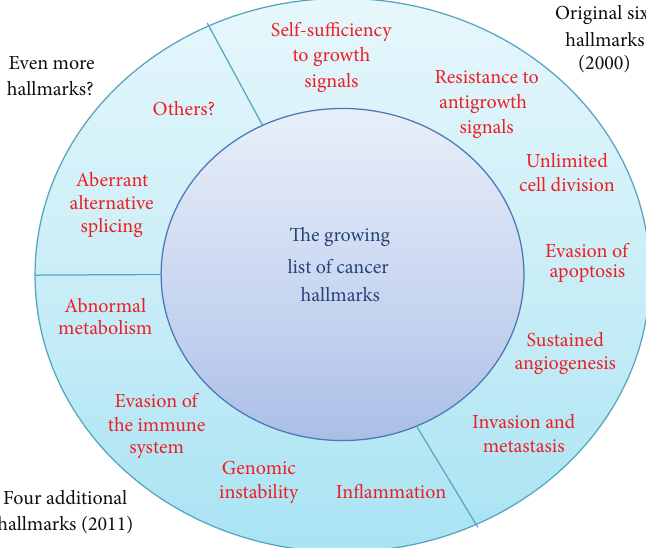
Figure 1: The original six hallmarks of cancer were proposed by Hanahan and Weinberg in 2000. Eleven years later, their list had grown to ten; but it could conceivably grow even further. An additional hallmark could be aberrant alternative splicing, in which the regulation of alternative splicing has gone astray systematically causing the inappropriate expression of multiple oncogenic splice isoforms.